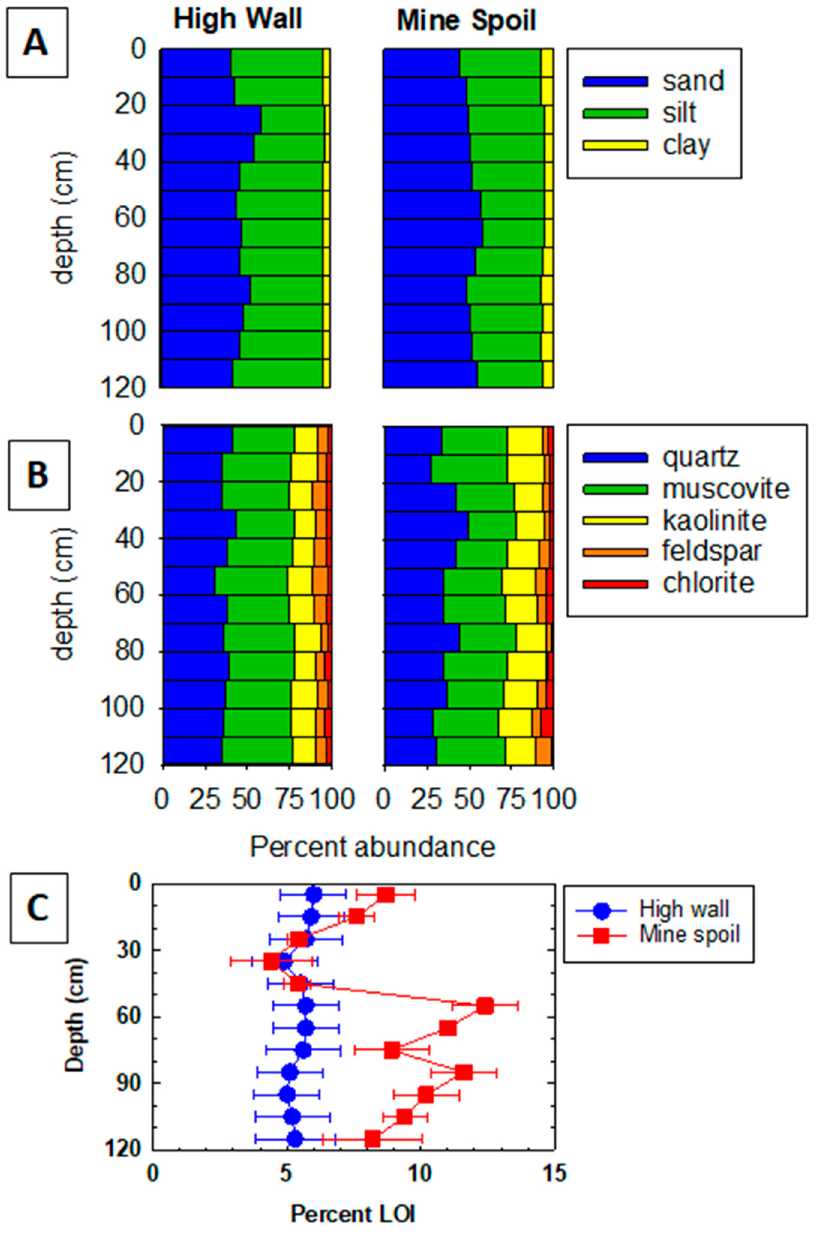
Figure 2. Comparison of high wall ( left ) and mine spoil ( right ) particle size analysis ( A ) and mineralogical composition ( B ); the bottom panel ( C ) shows loss on ignition (LOI) (error bars that represent one standard deviations for data points collected in triplicate).